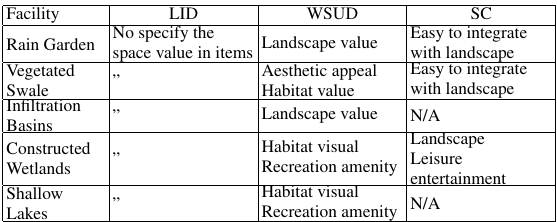
Table 3. Space value of sustainable stormwater management